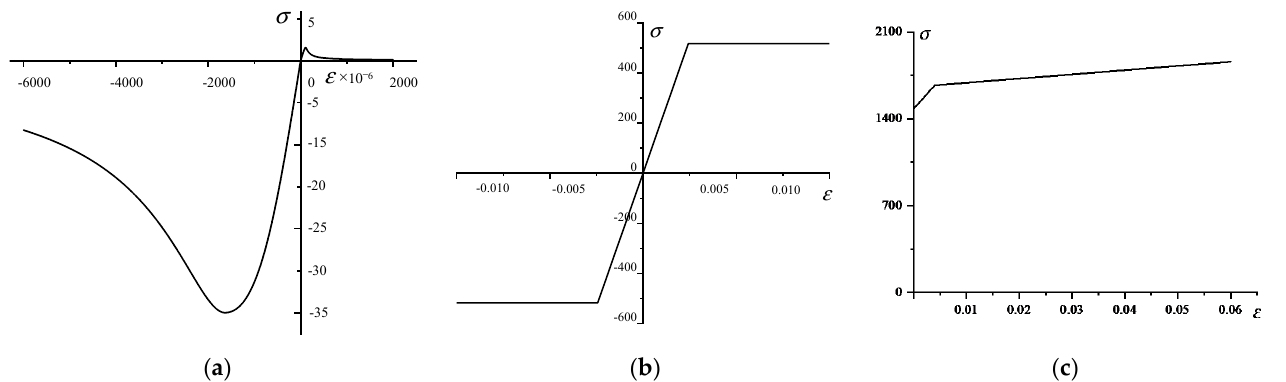
Figure 4. The constitutive models of materials: ( a ) concrete; ( b ) reinforcement; ( c ) prestressed steel strand.